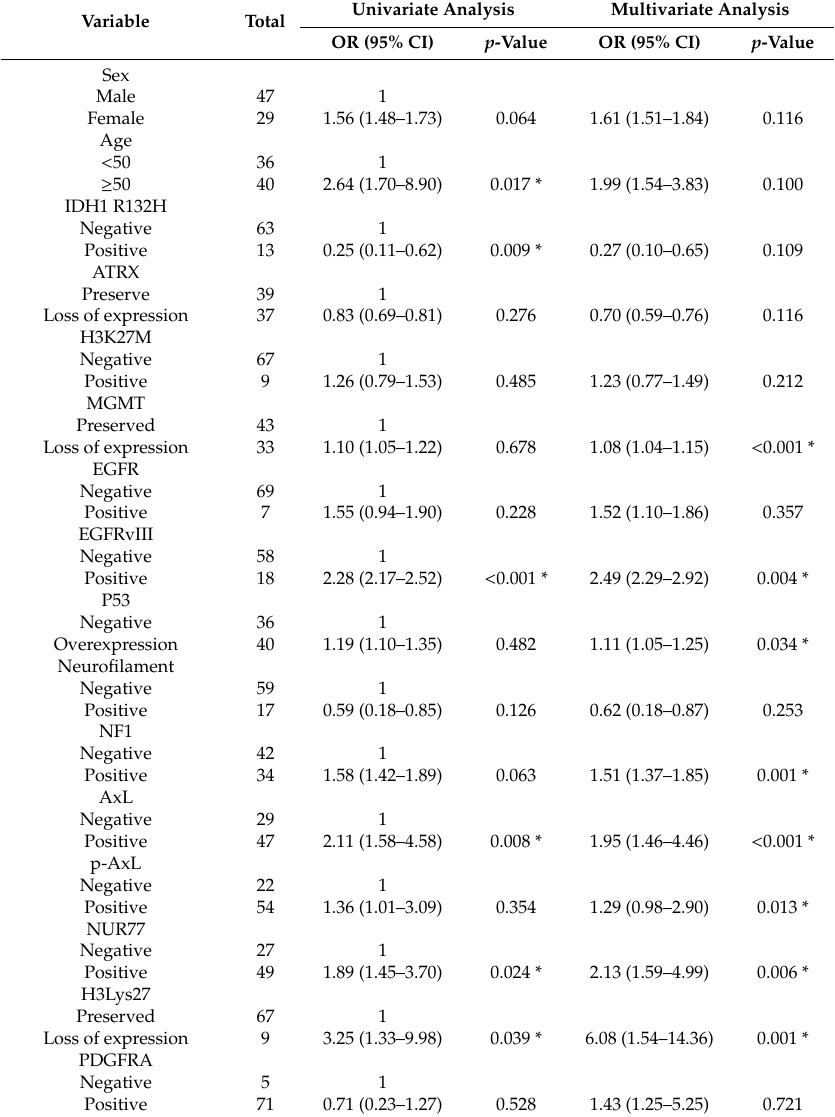
Table 2. Univariate and multivariate analysis of risk factors associated with KDELC2 expression.